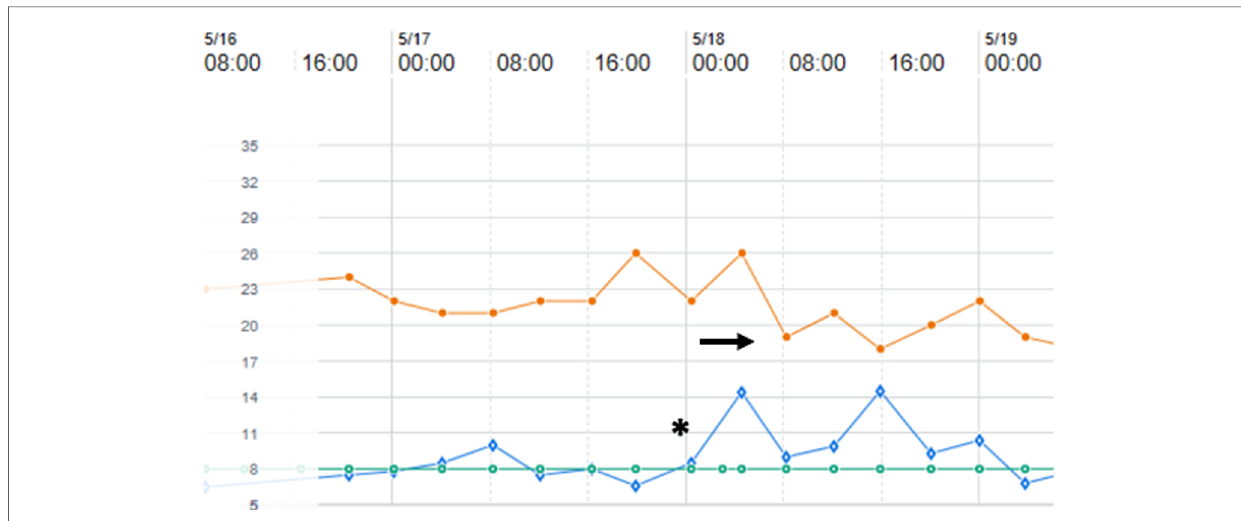
FIGURE 2 Ventilator data fl owsheet encompassing 18 – 21 days of age for a former 27 week, 1,160 gram premature infant with evolving chronic lung disease and supported on pressure-regulated volume control ventilation. As exhaled tidal volume (open diamonds) exceeds the set tidal volume (open circles) (asterix), note that the ventilator compensates by lowering peak inspiratory pressure (closed circles) (arrow).